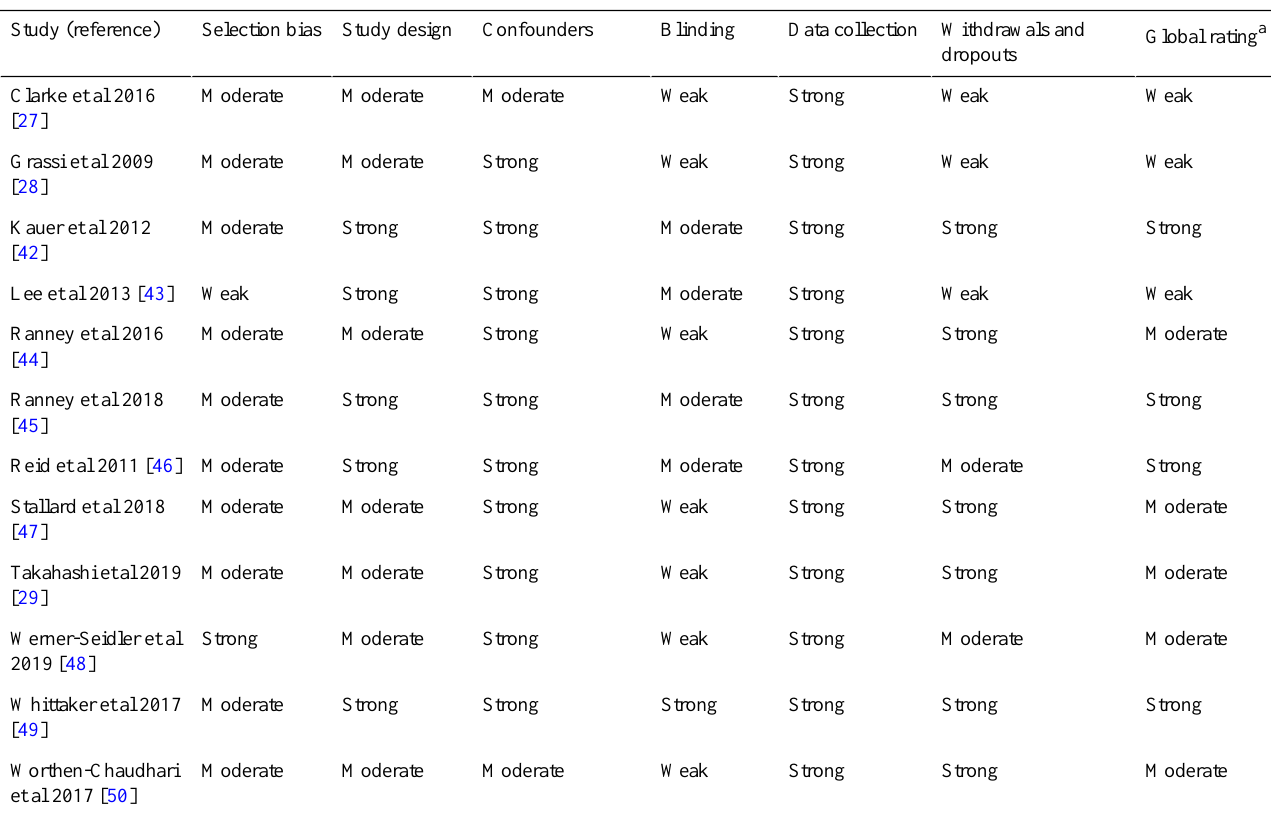
Table 1. Quality assessment of the articles included in